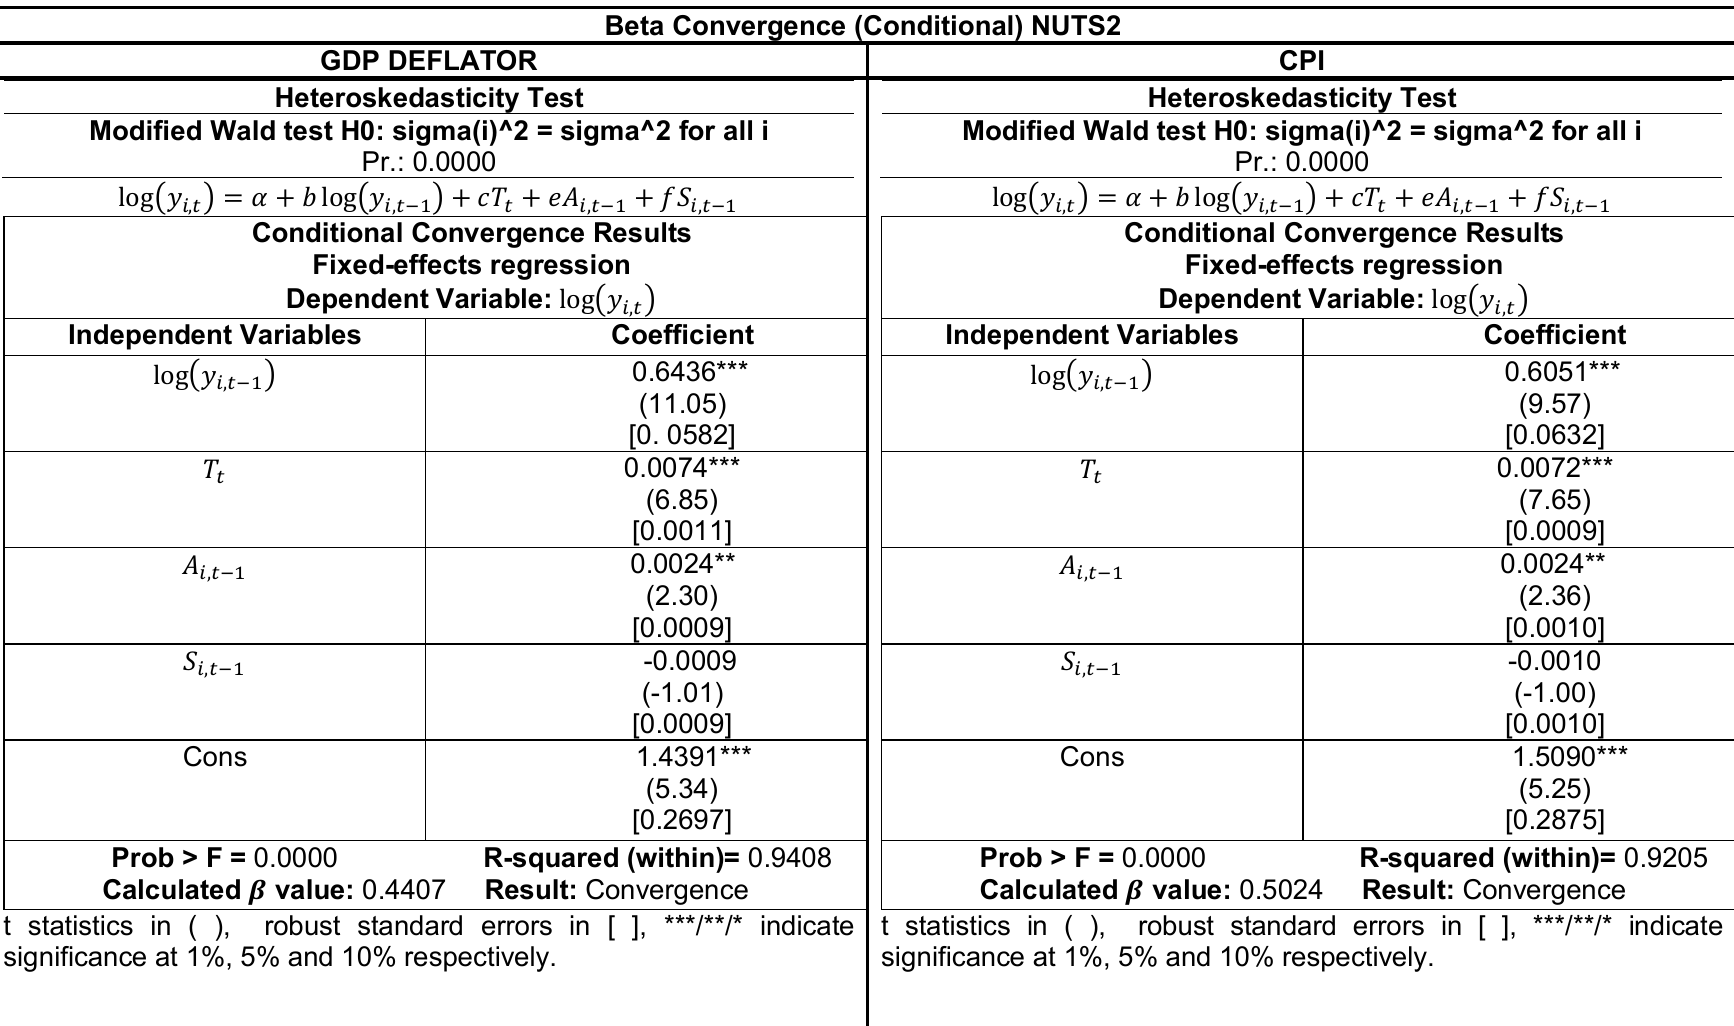
Table A.2: Comparison between GDP Deflator and CPI (2005-2017)